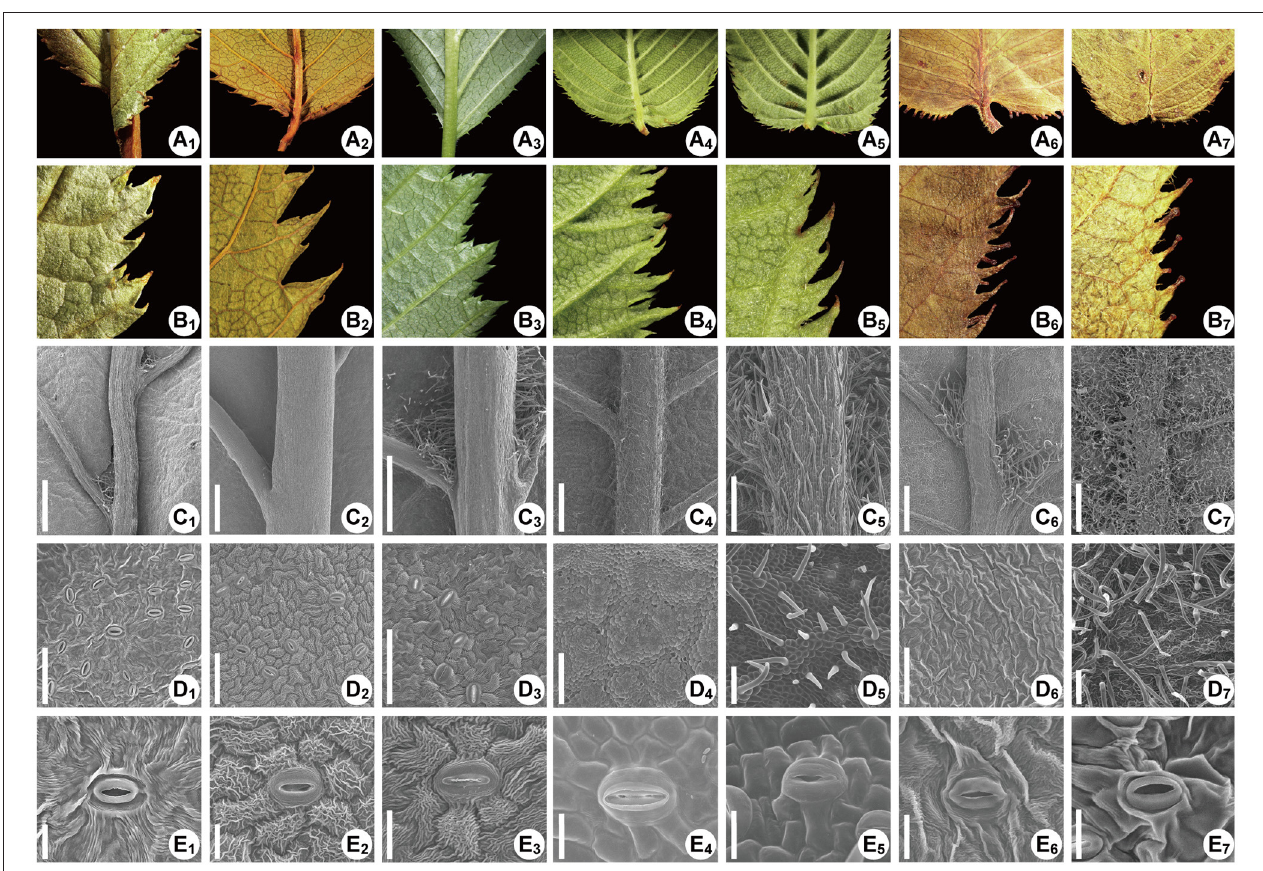
FIGURE 11 | The leaf morphology of the Maddenia species. The species are Prunus fujianensis , Prunus hypoleuca , P . incisoserrata , Prunus hypoxantha , P . wilsonii , Prunus gongshanensis, and Prunus himalayana , respectively in each row from left to right. (A 1 -A 7 ) Leave bases, showing the glandular teeth; (B 1 -B 7 ) Partial views of leaf margins, showing the shapes of teeth and glandular teeth; (C 1 -C 7 ) Abaxial leaves, showing the pubescence distribution; (D 1 -D 7 ) Detailed view of the pubescence on intercostal areas; (E 1 -E 7 ) Stomata and guard cells, showing the